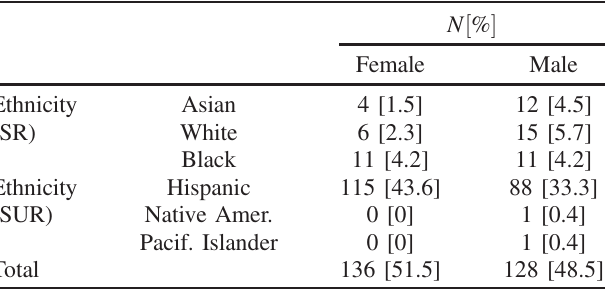
TABLE I. Demographics of University Modeling Instruction sections in the sample ð N ¼ 264 Þ . Counts and percentages are given for gender and for ethnic representation, grouping by statistically well- or overrepresented (SR) and statistically under- represented